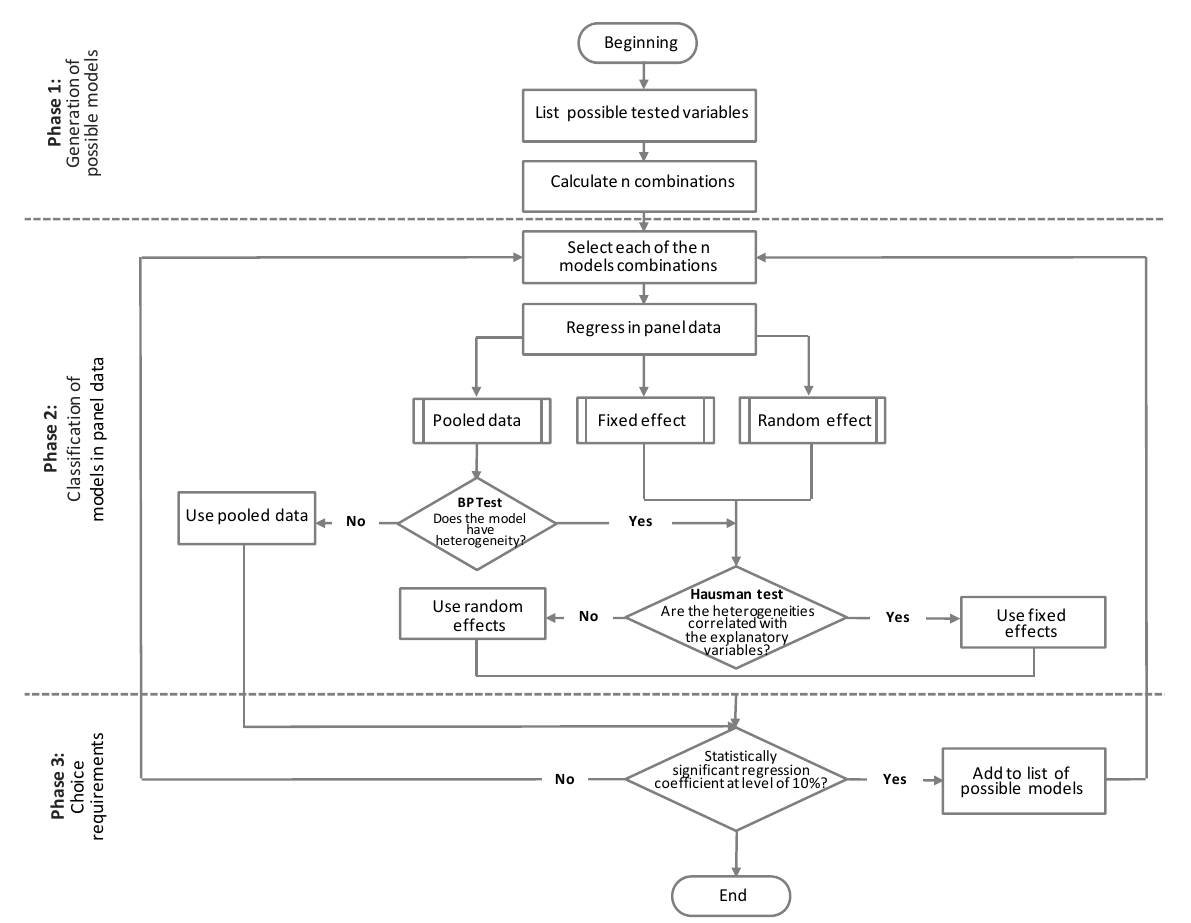
Figure 1. General view of the proposed automatic model ‐ selection technique for panel data regressions.